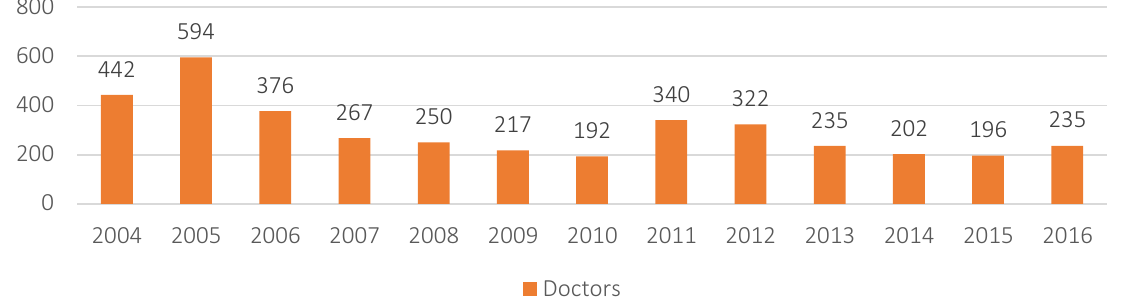
Figure 1. Issued proof of equivalence of education in Slovakia (in persons)